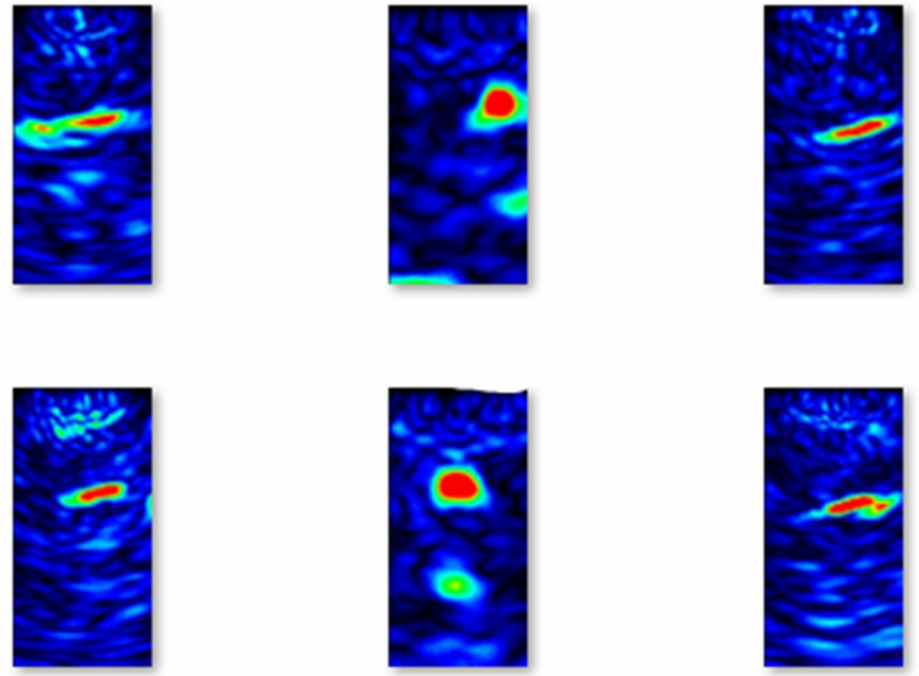
Figure 10. Examples of B-scans with flaws from the testing